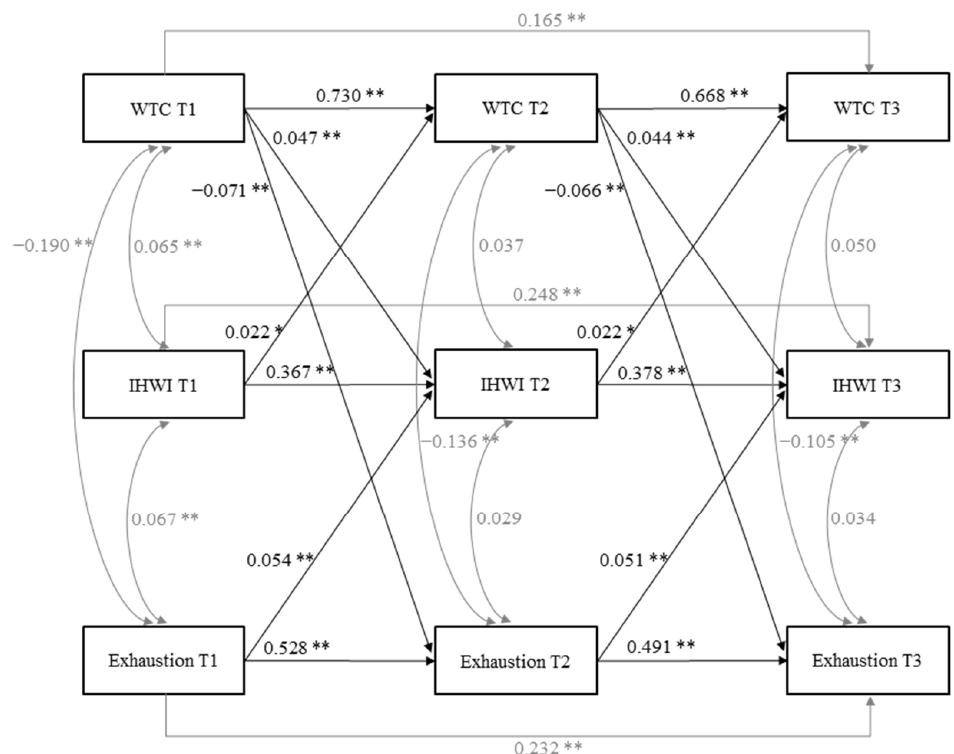
Figure 3. Final model (M5) with standardized coefficients for WTC, IHWI, and exhaustion. For clarity, control variables (gender, age, education level, living with a partner, underage child in household, weekly working hours, regular day work, and requirement level) are not shown. * p < 0.01. ** p < 0.001.